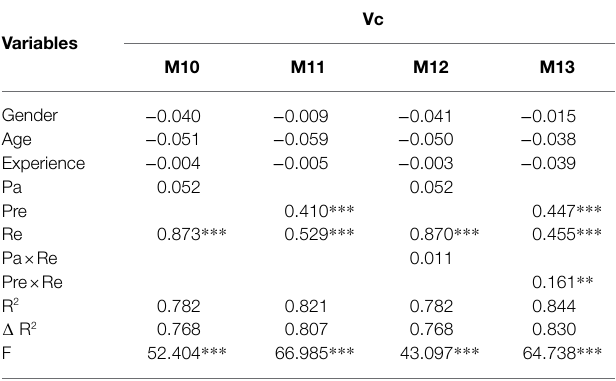
TABLE 6 | Mediation effect test of relational capital.